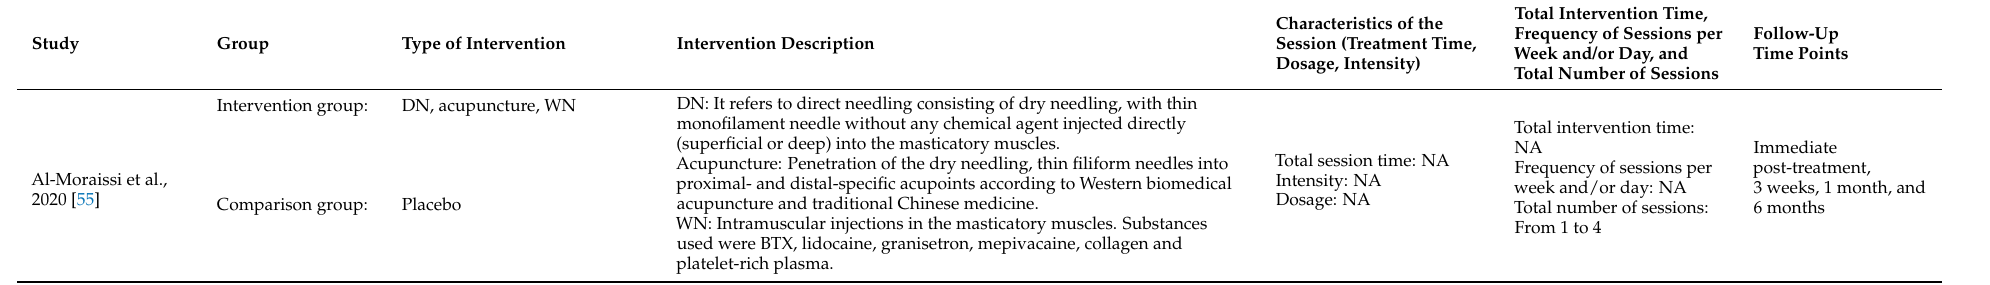
Table 2. Intervention’s characteristics of the included systematic